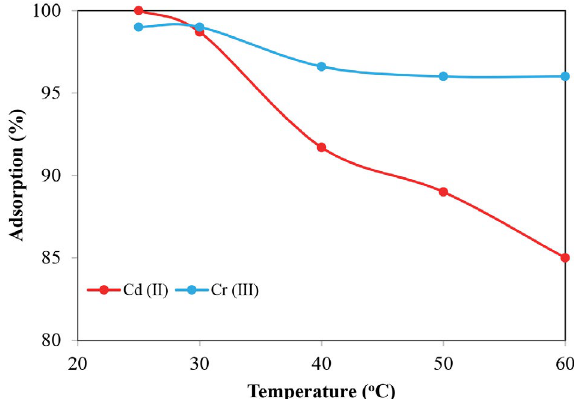
Fig. 9: The effect of temperature on the cadmium and chromium in conditions in terms of (cadmium pH: 6, chromium pH: 7, initial concentration of metal ions 20 mg/L, time 50 min and adsorbent dosage 20